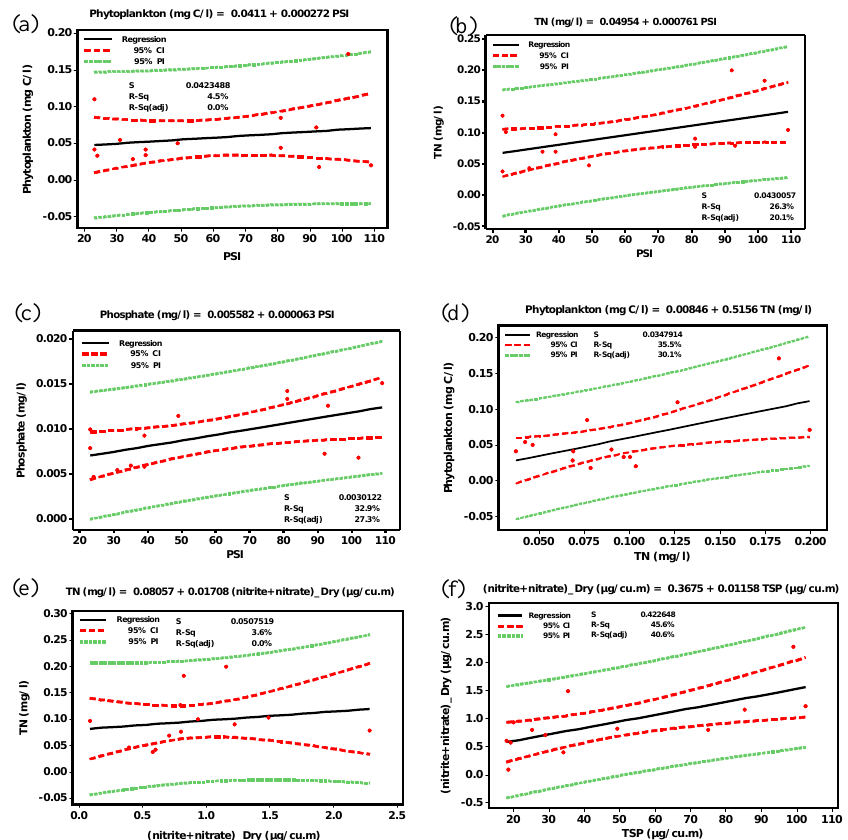
Fig. 4. Relationship between (a) Pollutant Standards Index (PSI) and phytoplankton in seawater, (b) PSI and TN in seawater and (c) PSI and phosphate in seawater; (d) phytoplankton and TN in seawater; (e) nitrate-nitrogen from dry atmospheric deposition and TN in seawater, and (f) TSP and nitrate-nitrogen from dry atmospheric deposition. Note: Dry – Dry atmospheric